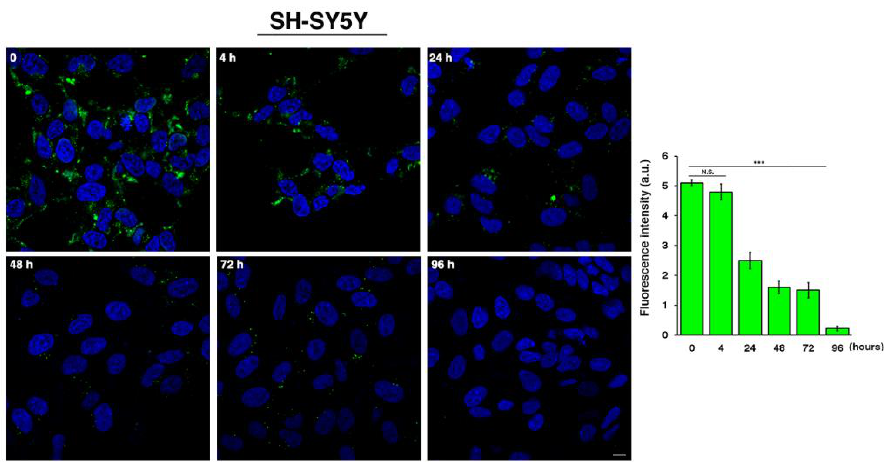
Figure 7. Analysis of MS3 biological stability by time-course experiments. SH-SY5Y cells were incubated for 24 h with FITC-MS3 (green). After removal of residual aptamers by extensive washings, cells were incubated in culture medium for the different indicated times. Nuclei were counterstained with DAPI. Images were acquired with confocal microscope. Scale bar, 6 µm. Mean fluorescence intensity normalized per cell area (arbitrary unit, a.u.) of three independent experiments is shown (left graph), n > 40 cells; error bars, mean ± SD. *** p < 0.0001, Student t -test; N.S., not significant.